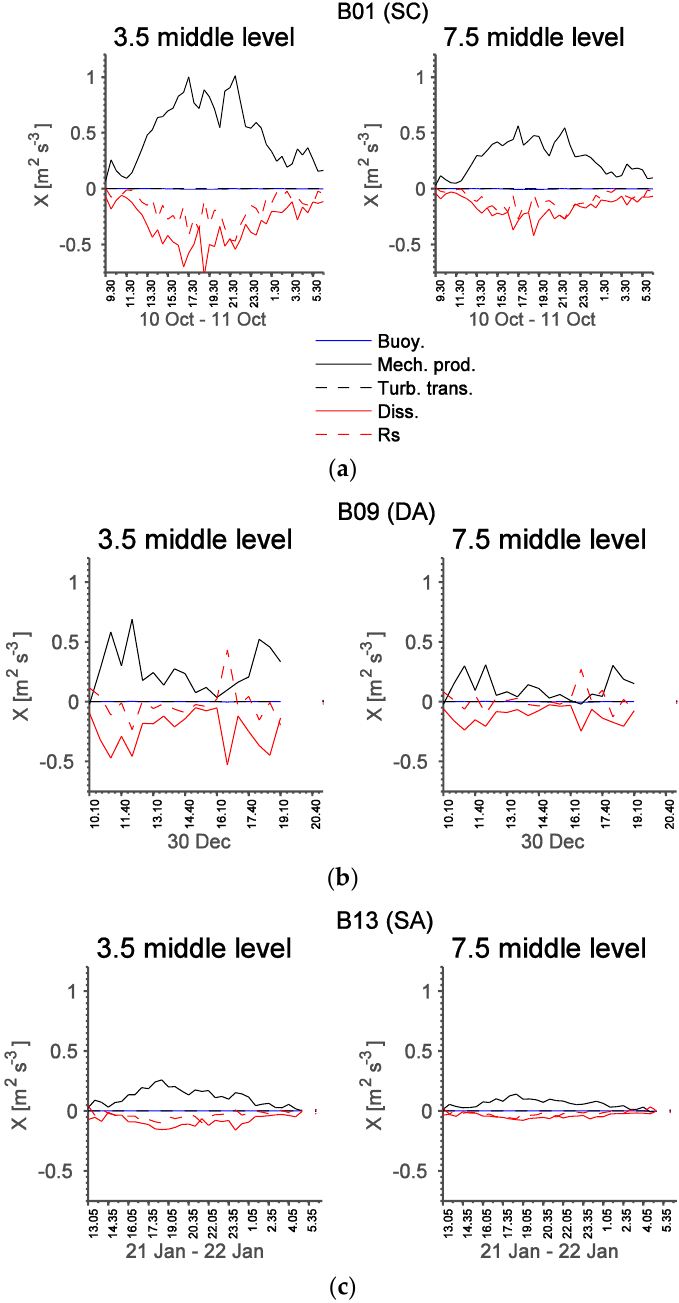
Figure 19. The turbulence kinetic energy (TKE) terms calculated on the two middle levels: 3.5 m (left) and 7.5 m (right). Term III (mechanical production) in the solid black line, term II (buoyant production) is the solid blue, dissipation is the solid red line, and the residual term is in dashed red. ( a ) B01 (SC), ( b ) B09 (DA), and ( c ) B13 (SA). The correlation coefficient between the mechanical production and dissipation is ~−0.9, and between the buoyancy term and residual is 0.8 and 0.5 on the 3.5 and 7.5 middle levels, respectively.